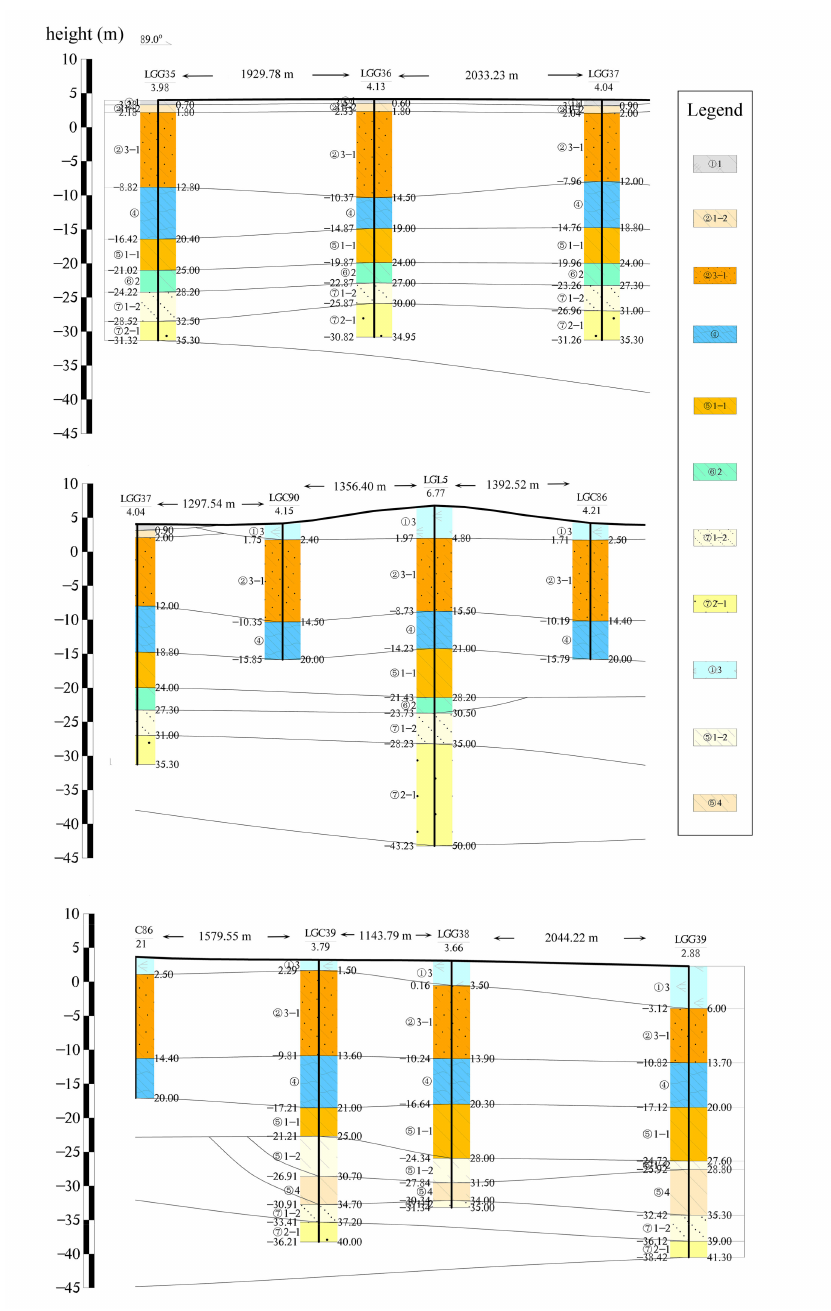
Figure 10. Engineering geologic layers of profile line I-I’. The location of profile line I-I’ is indicated in Figure